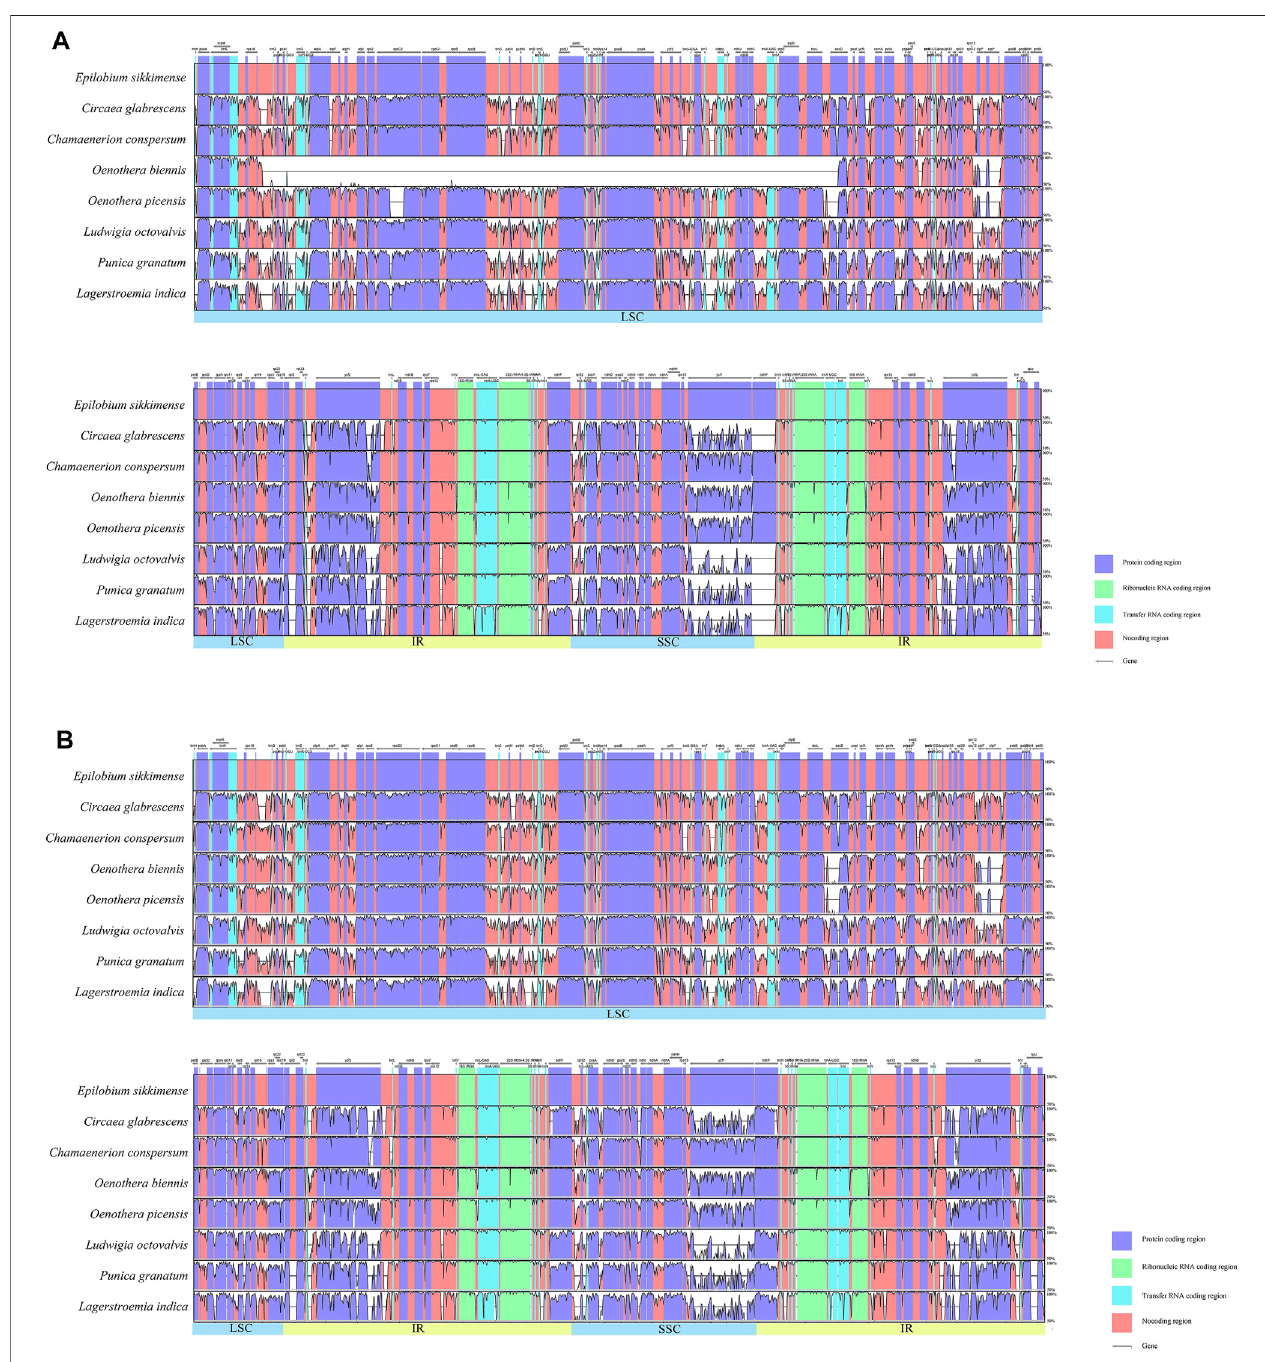
FIGURE 2 | Sequence alignment of representative samples from fi ve genera of Onagraceae and two outgroups using the mVISTA program (alignment of all 33 samplesareshownin SupplementaryFigureS2 ).Acut-offof70%similaritywasusedfortheplot,andtheY-scalerepresentsthepercentagesimilarityrangingfrom50 to 100%. Blue represents coding regions, and pink represents non-coding regions. (A) : LAGAN method, the large empty part of the Oenothera biennis graph is the inverted region; (B) : Shuf fl e LAGAN method.